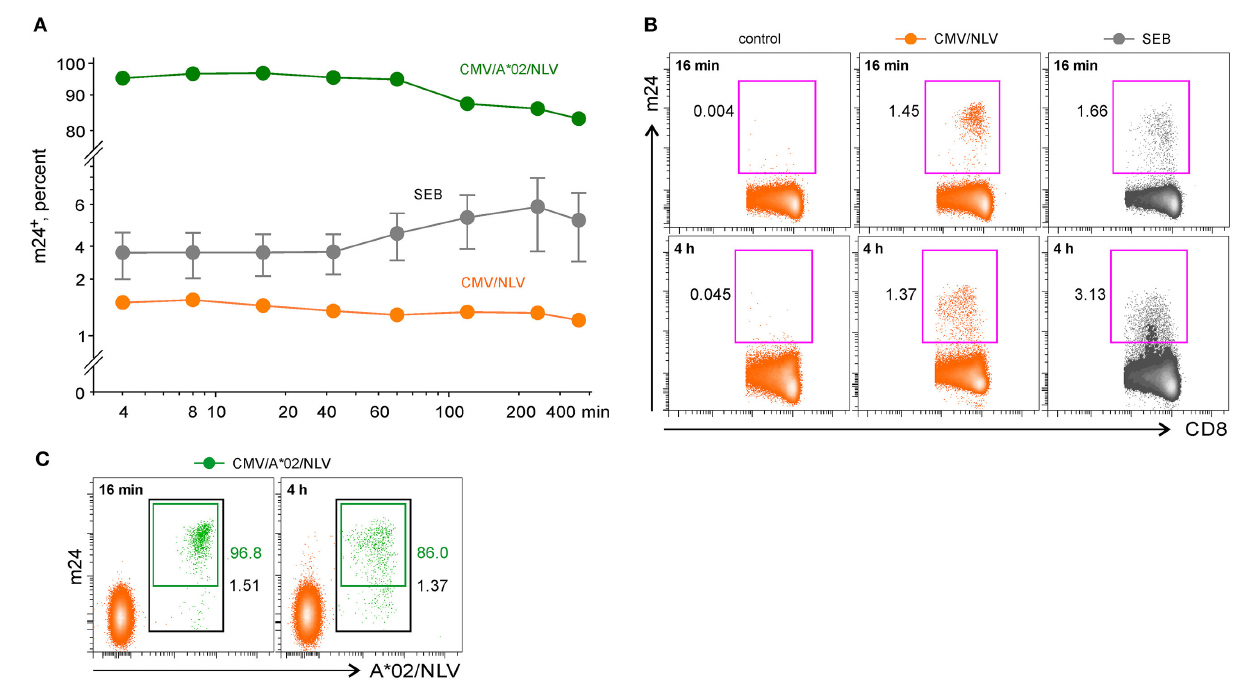
FIGURE 4 | The flow cytometry assessment of antigen-specific CD8 + WB T cells by staining activated β 2 -integrins with m24 Ab. Cells were stained with m24 Ab, treated with EDTA afterward, and then stained with CD3, CD4, and CD8 Abs; gating strategy is displayed in Figure 2A . Percentages of m24 + cells among total CD8 + T cells are indicated. (A) The time course of m24 Ab staining following incubation of WB cells with SEB (gray, three donors, presented as mean ± SEM), or CMV/NLV peptide (orange, one donor; green, the same donor, but additionally stained with A*02/NLV multimers), for 4, 8, 16, 32, 60, 120, 240, or 360min. Background from the relevant unstimulated sample was subtracted. Numbers indicate frequencies among CD8 + T cells in %. (B) Examples of m24 Ab staining obtained after 16 or 240min, i.e., 4h without stimulation (control), in the presence of CMV/NLV peptide, or after stimulation with SEB. (C) Combined m24 Ab and CMV/NLV tetramer staining of the CMV-specific CD8 + T cells. Percentages of A*02/NLV + within the CD8 + subset and of m24 + within the A*02/NLV + cells are indicated in black and green,